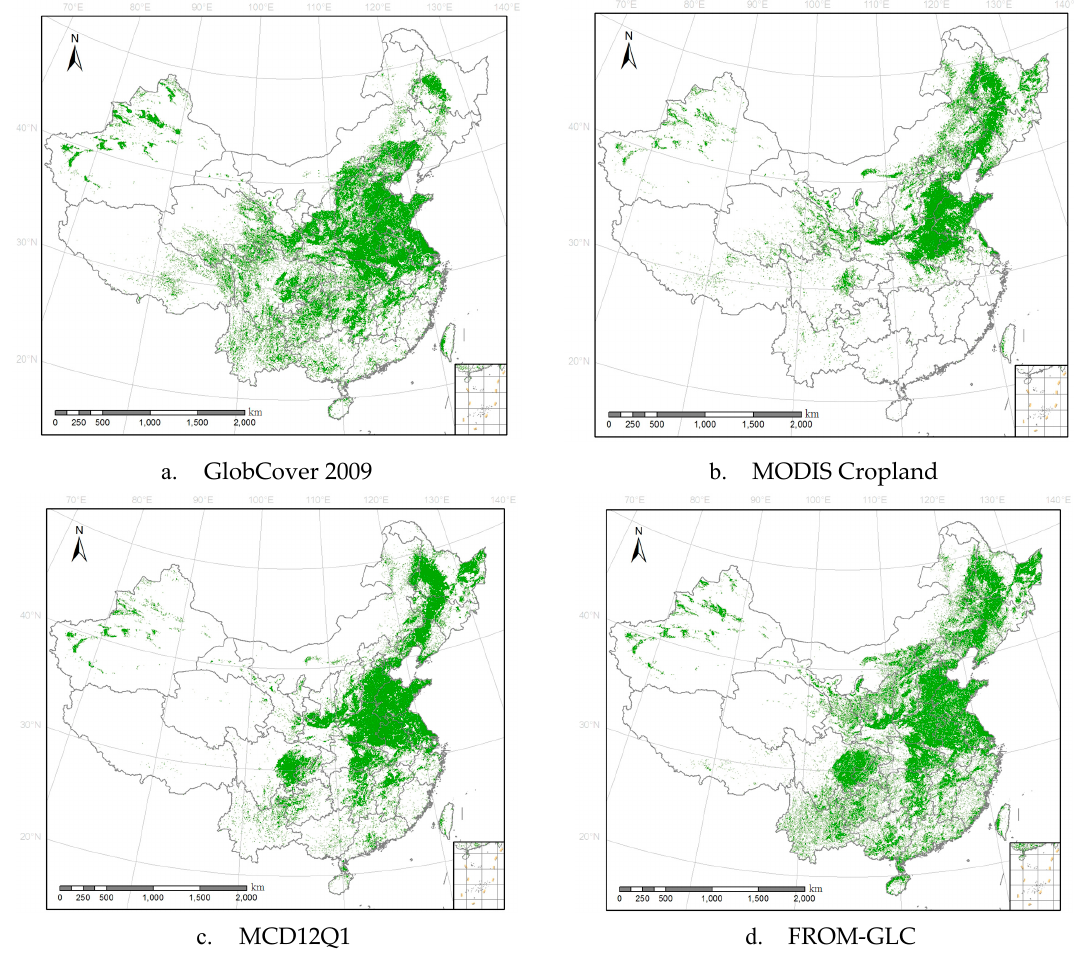
Table 1. The remote sensing cropland products used in the study.